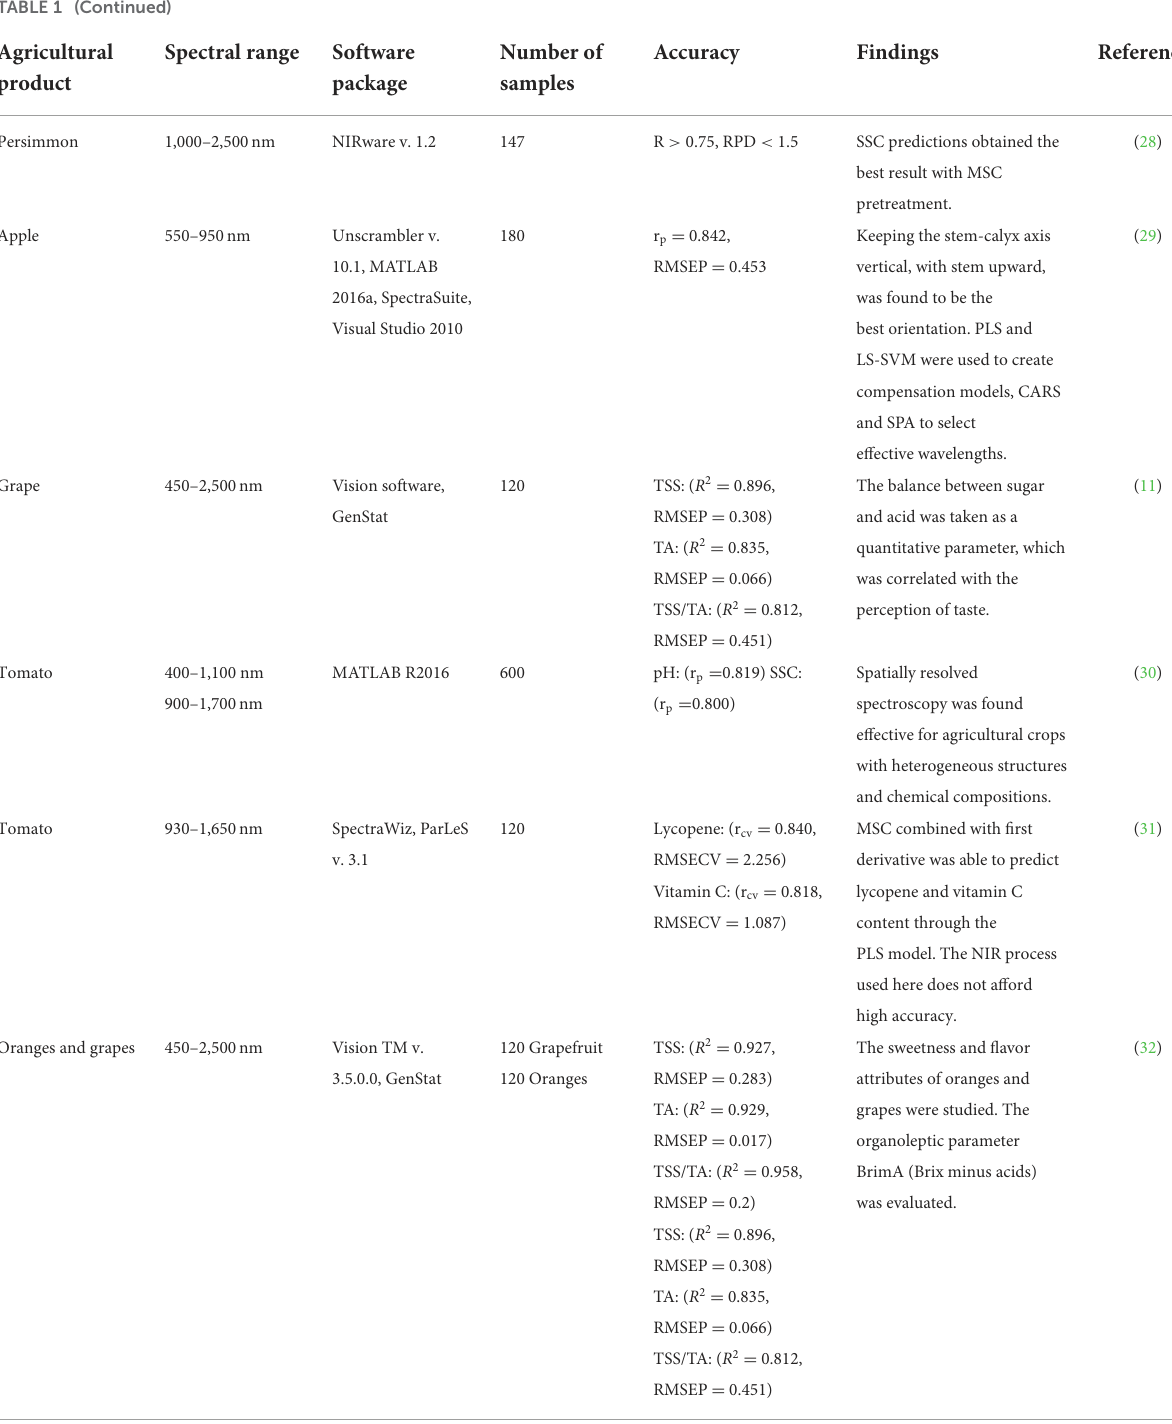
SSC,solublesolidcontent;RMSEP,rootmeansquareerrorofprediction;SSOM,supervisedself-organizingmap;MC,moisturecontent;TA,titratableacidity;TSS,totalsolublesolids;GA, geneticalgorithm;RPD,residualpredictivedeviation;MSV,multiplicativescattercorrection;MC-UVE,MontiCarlo–uninformativevariableelimination;SPA-MLR,successiveprojection algorithm–multiplelinearregression;CARS,competitiveadaptivereweightedsampling;RMSECV,root-mean-squareerrorofcross-validation. results than with other factors, such as TA and pH